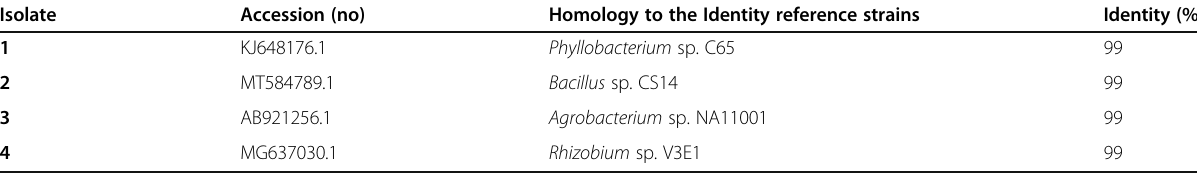
Table 5 Sequence analysis of 16S rDNA for rhizobacterial strains associated with root nodule of Acacia cyanophylla Isolate Accession (no) Homology to the Identity reference strains Identity